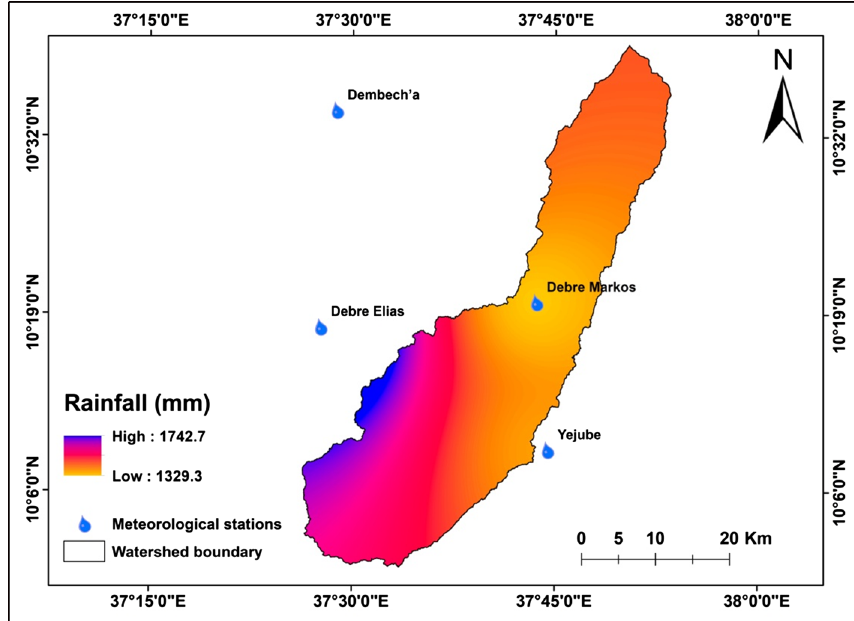
Fig. 7 Rainfall map of the study